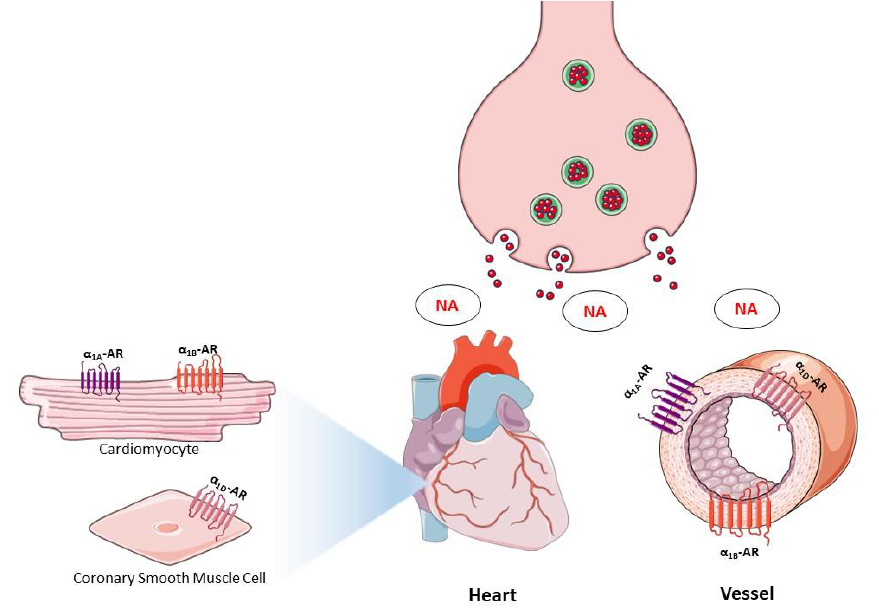
ff erential expressions of α Figure 3. Differential expressions of α 1 -ARs in the cardiovascular system. NA: noradrenaline. Figure 3. Di 1 -ARs in the cardiovascular system. NA: